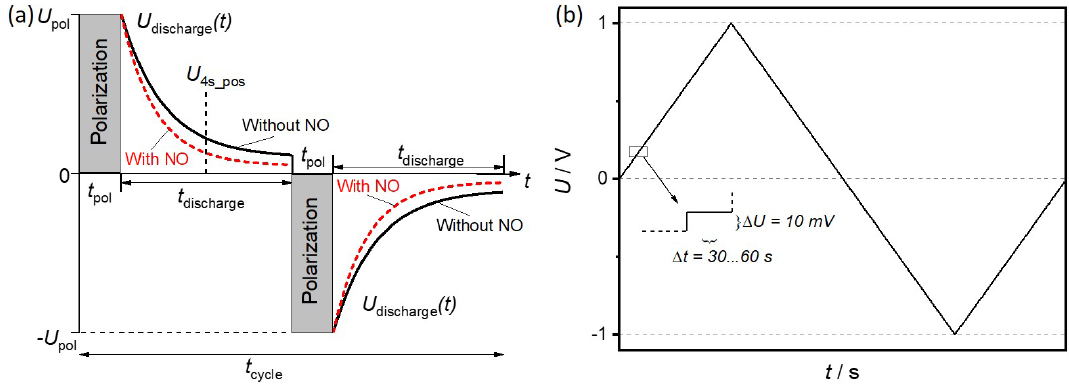
Figure 1. Scheme of a pulsed polarization cycle (a) , and the U – I measurements (b) .